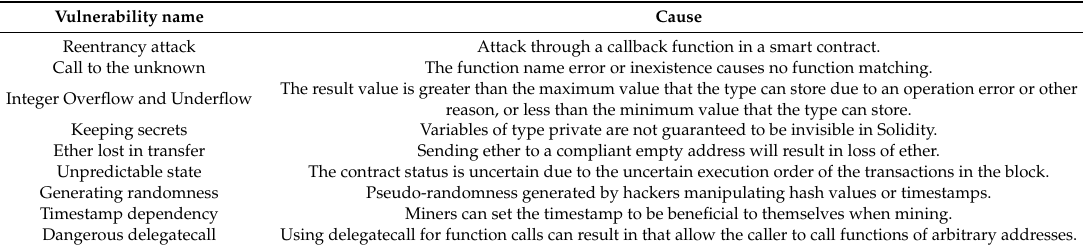
Table 7. Common smart contract vulnerabilities.